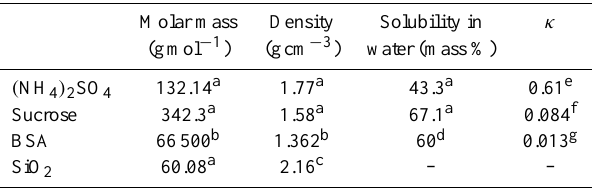
Table 1. Thermodynamic properties of components used in this